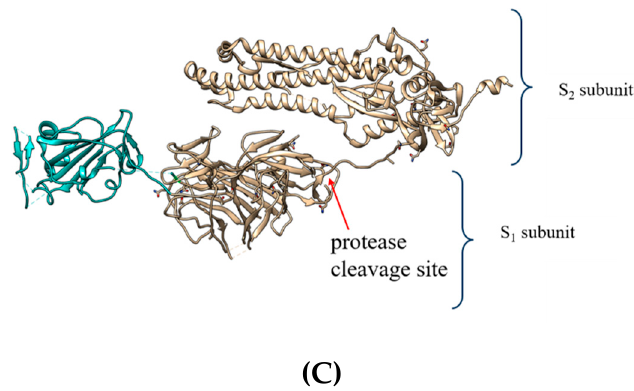
Figure 1. Overall structure of the S protein protomer of SARS-CoV-2. ( A ) Each monomer of the S protein protomer is represented by a different color. ( B ) Receptor-binding sites of the chains A, B, and C of the S protein are highlighted in blue, purple and green color, respectively. Glycan ligands have been omitted for simplicity. ( C ) Monomer of the SARS-CoV2 spike protein during the receptor-accessible conformation. The receptor binding domain (RBD) is shown in cyan. Visualized by USCF Chimera [80]. PDB ID: 6VSB.